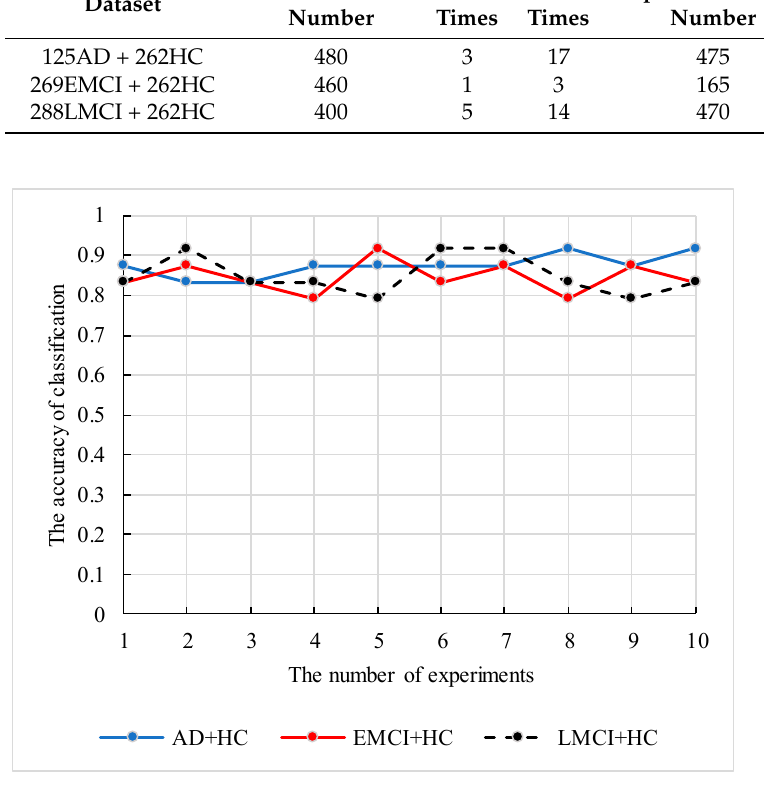
Figure 12. The classification accuracy curve of the proposed model based on three